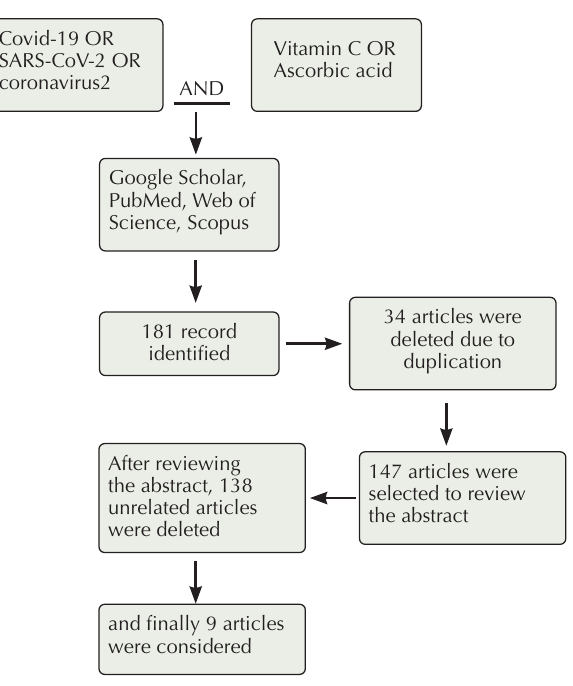
Figure 1. Summary of search strategy and paper